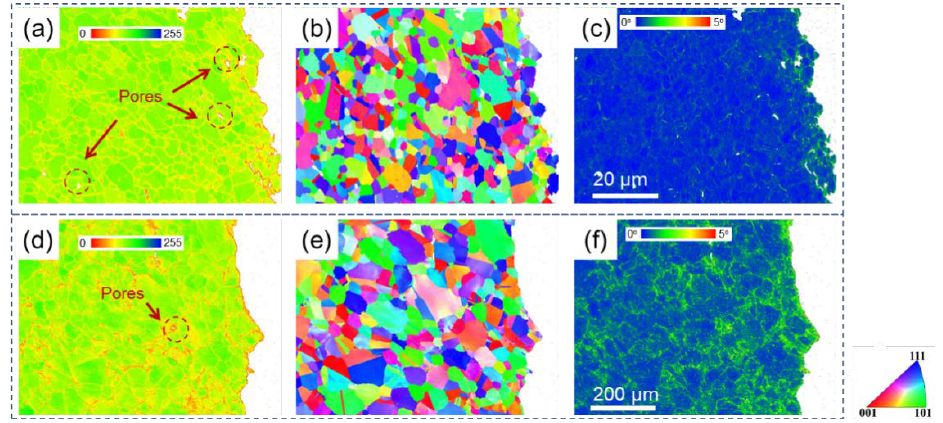
Figure 6. BC ( a , d ), IPF ( b , e ), and KAM ( c , f ) maps for SL ( a – c ) and SH ( d – f ) near fracture at 750 °C.